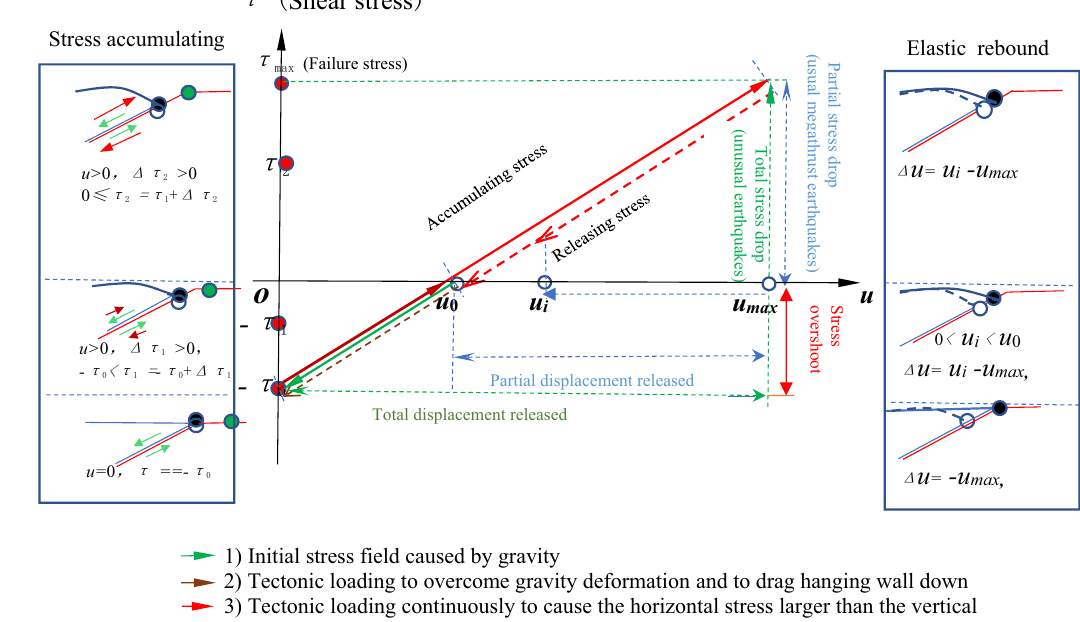
Figure 4. Accumulating and releasing progress of stress at a point on the fault surface of the hanging wall of the Tohoku-Oki